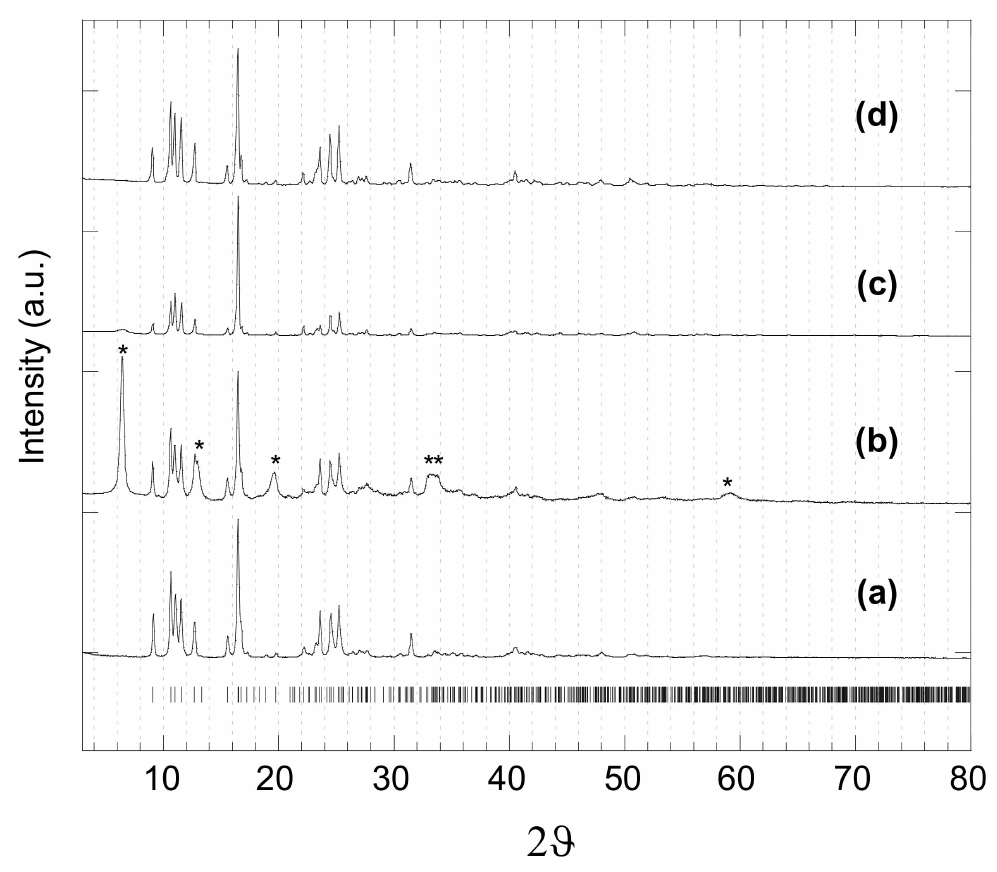
Figure 5. XRPD pattern of [Zn(4,4 (cid:48) -bipy) 2 (OAc) 2 ] ∞ samples prepared by the sonochemical process: ( a ) sample A (with EtOH-100); ( b ) sample B (with EtOH-96); ( c ) sample C (like sample B but methanol (MeOH) washed; ( d ) sample D (prepared in aqueous solution and washed in methanol). The lower vertical bars represent the reflection position of the [Zn(4,4 (cid:48) -bipy) 2 (OAc) 2 ] ∞ solvothermal sample reported in the literature